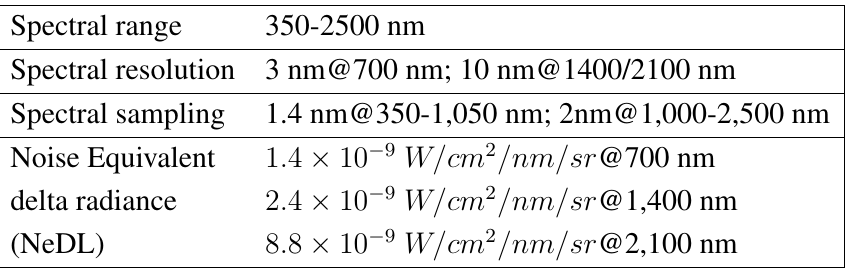
Table 3 . The characteristics of the FieldSpec